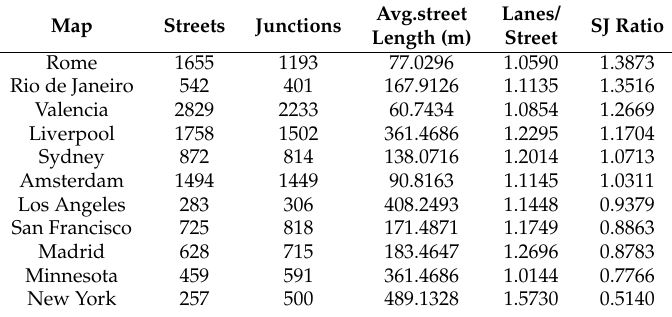
Table 7. Map characteristics. SJ, street